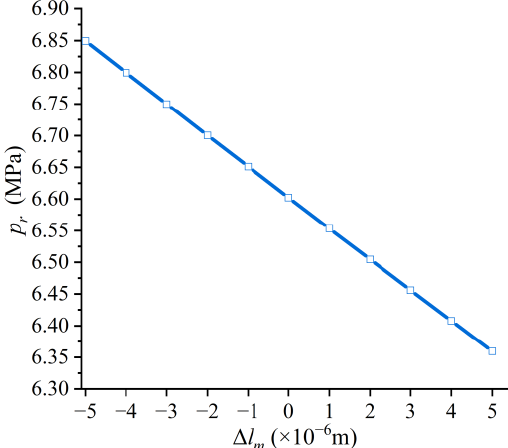
Figure 24. Shunt wedge error dependence of balance pressure.